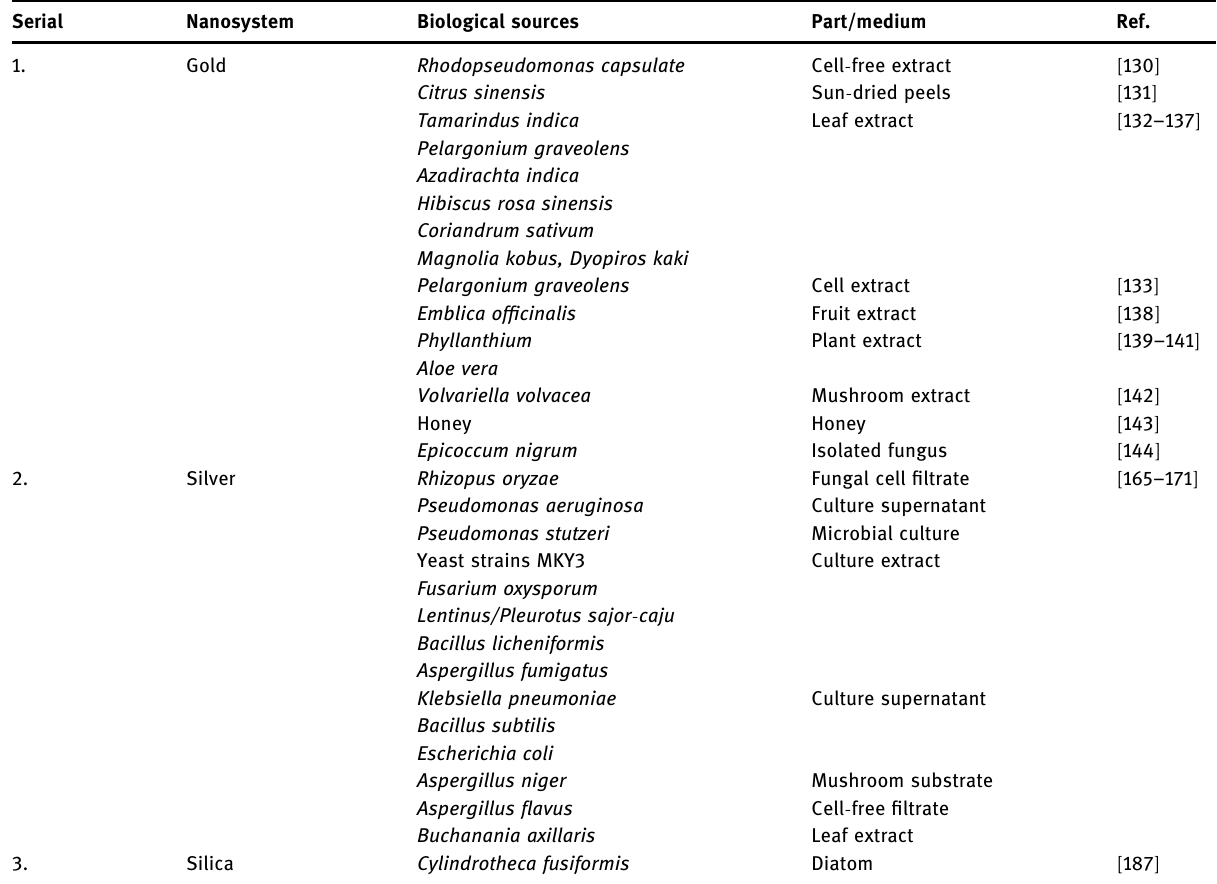
Table 2: Preparation of di ff erent non - polymeric nanosystems from various bio - sources